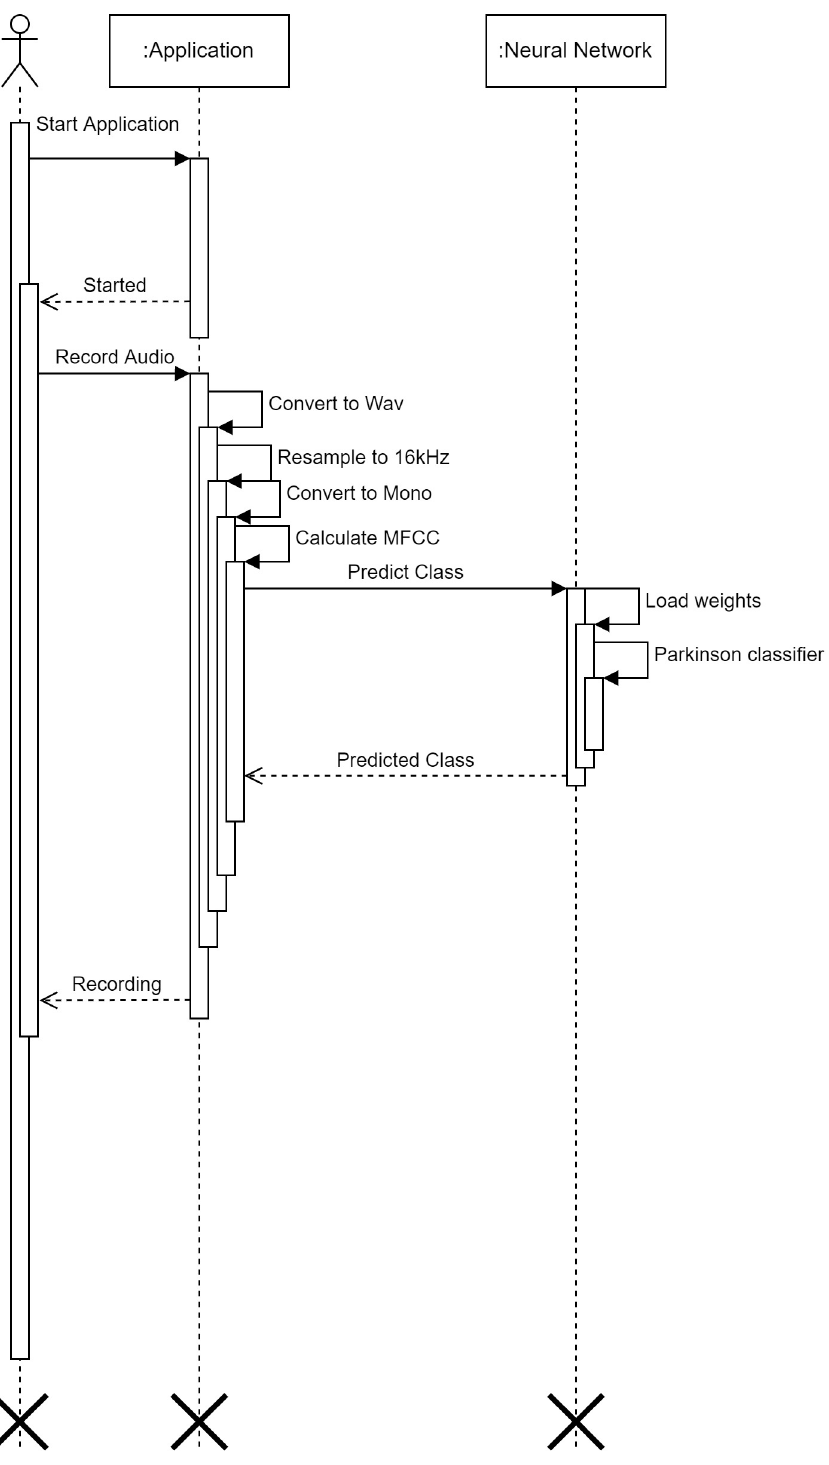
Figure 2. Process sequence diagram (Symbol ’X’ depicts the end of the